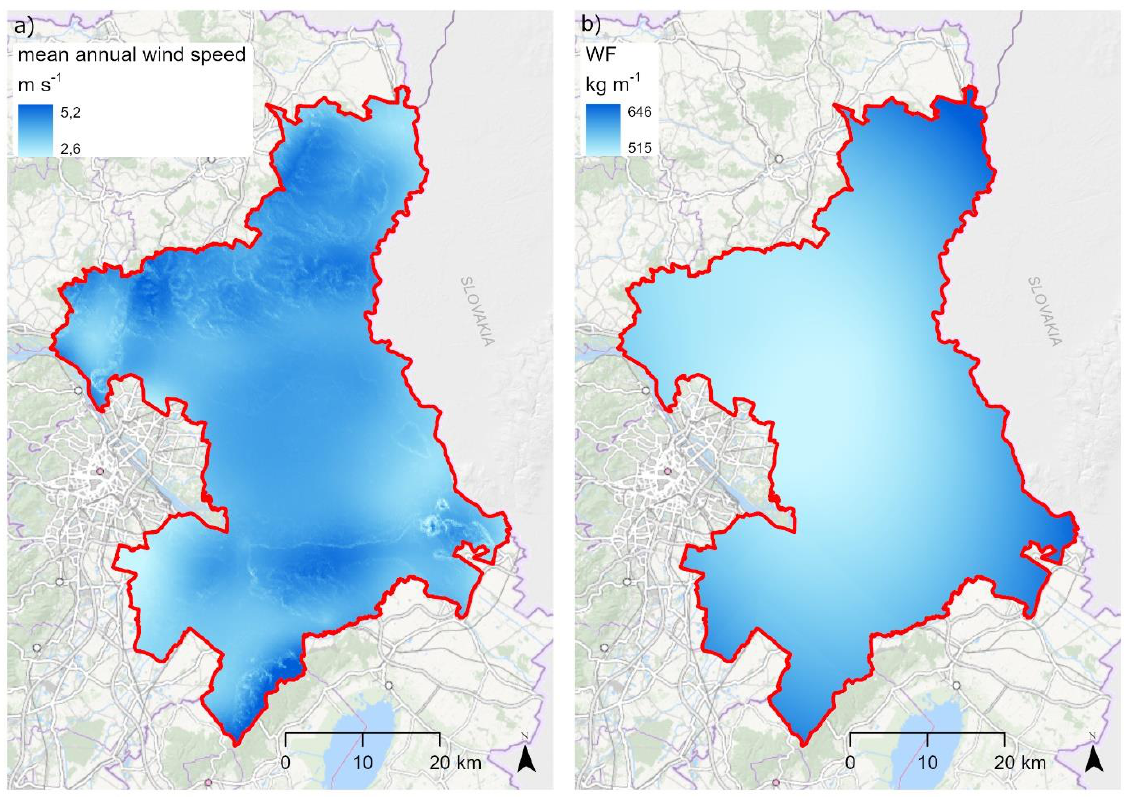
Figure 4. Climate/weather factor of ( a ) DIN 19706, represented by mean annual wind speed (m s − 1 ), and ( b ) weather factor (WF) of revised wind erosion equation (kg m − 1 ) by Equation